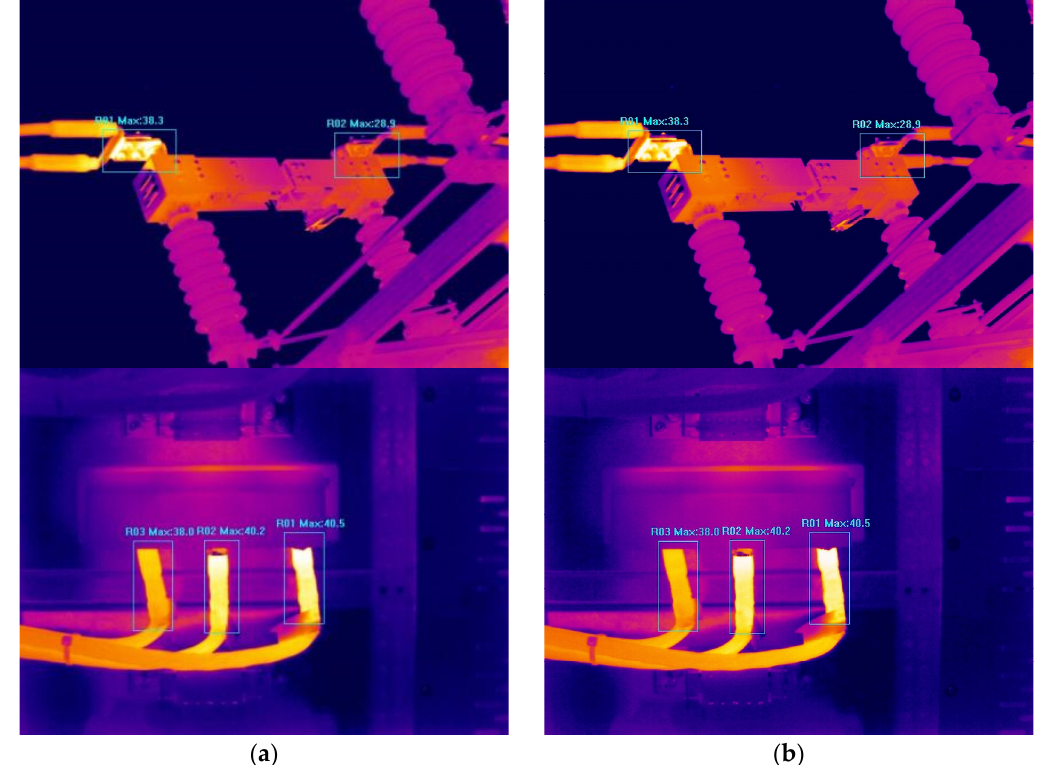
Figure 2. Renderings: ( a ) low-resolution graphs; and ( b ) high-resolution graphs.